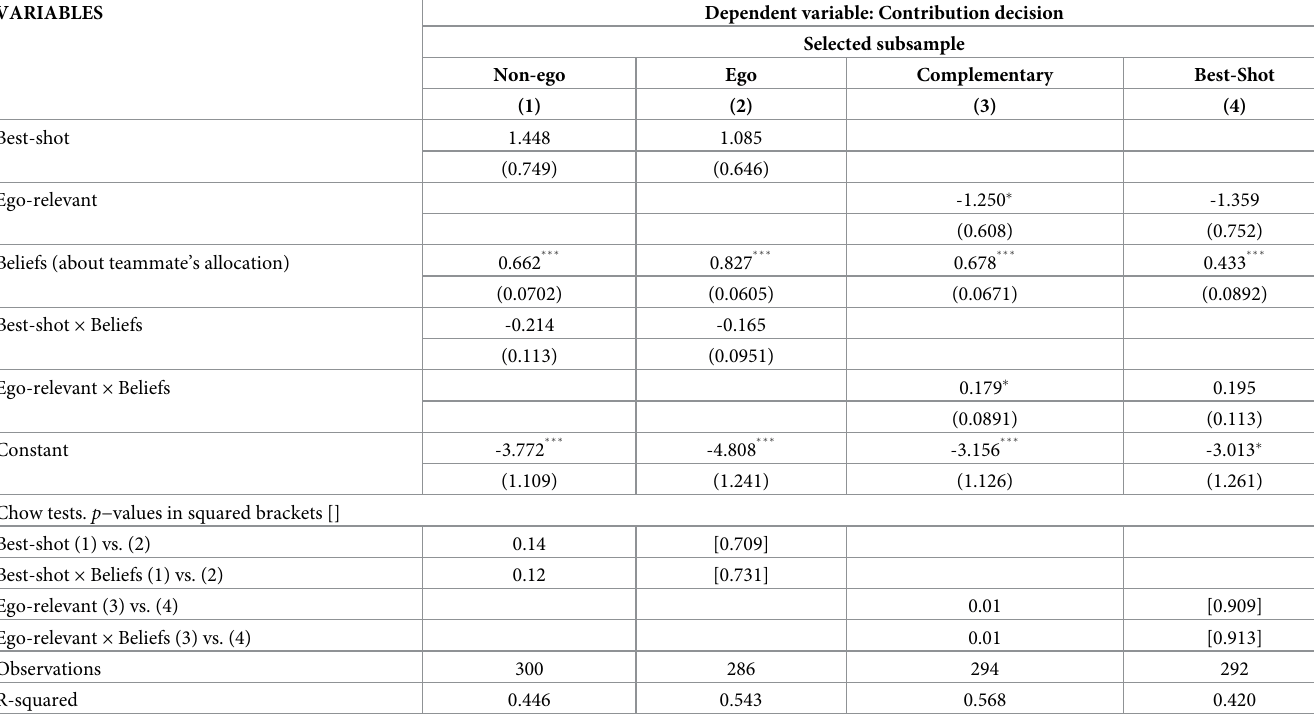
Table 5. OLS results for combined effects of ego-relevance, team production function and beliefs about teammate’s contributions. p − values corresponding to tests for seemingly unrelated estimations reported in brackets next to the Chow test